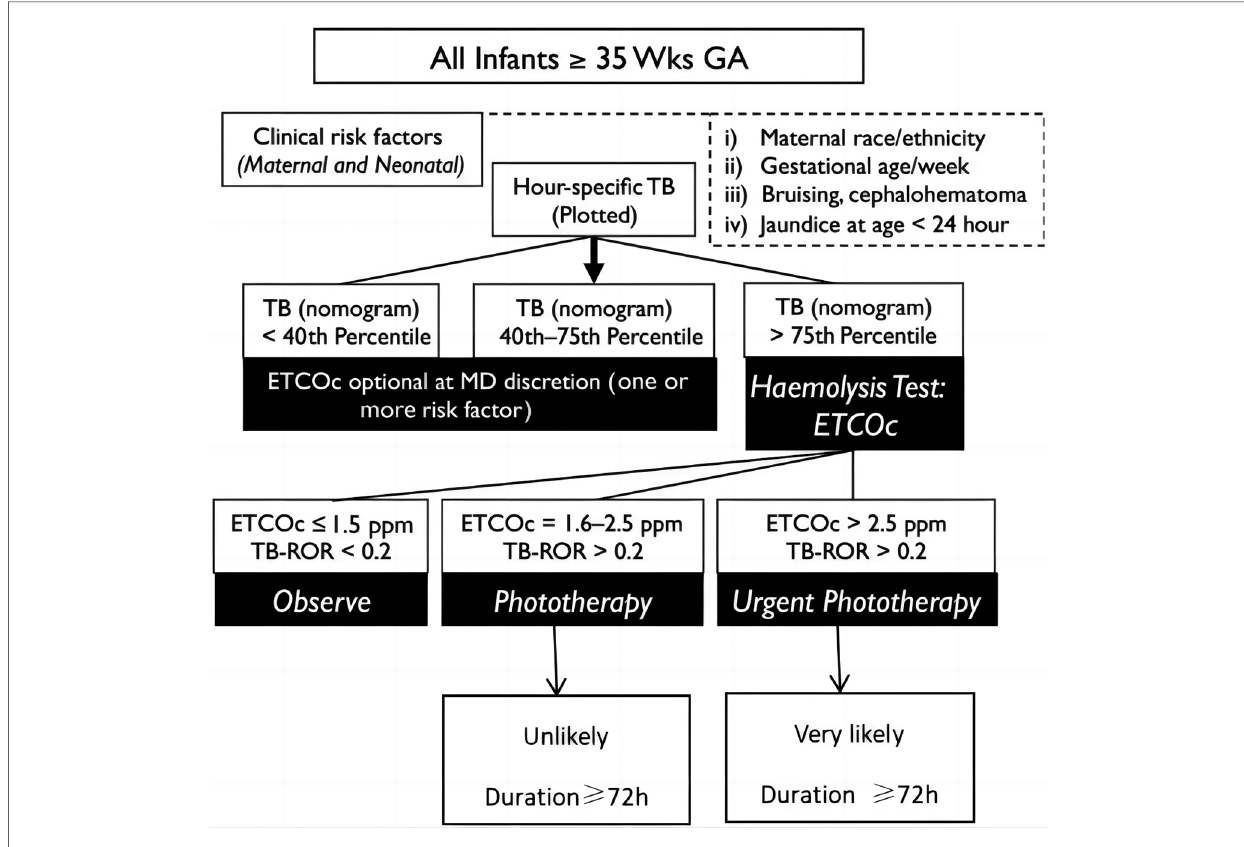
FIGURE 3 Clinical interpretative algorithm (supplementary version).TB-ROR, total serum/plasma bilirubin rate of rise (mg/dl/h; GA, gestational age; TB, total bilirubin; ETCOc, end-tidal carbon monoxide corrected to ambient carbon